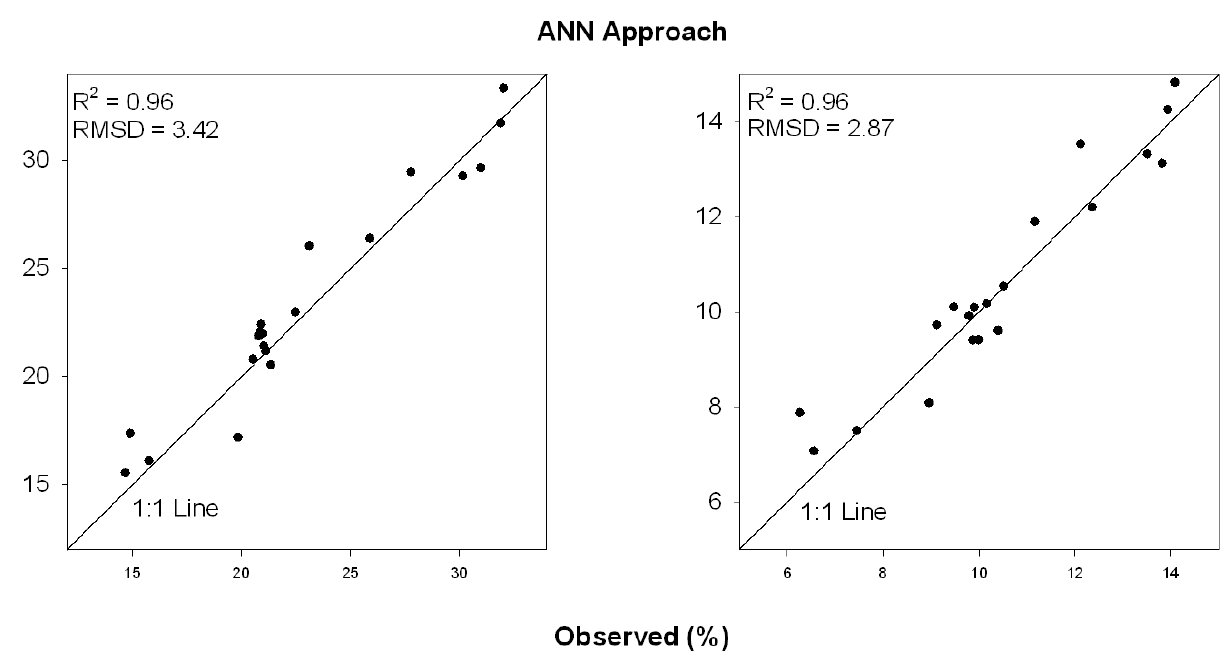
Fig. 2. Comparison of simulated and observed values of FC and PWP using kNN, ANN and PTFs developed